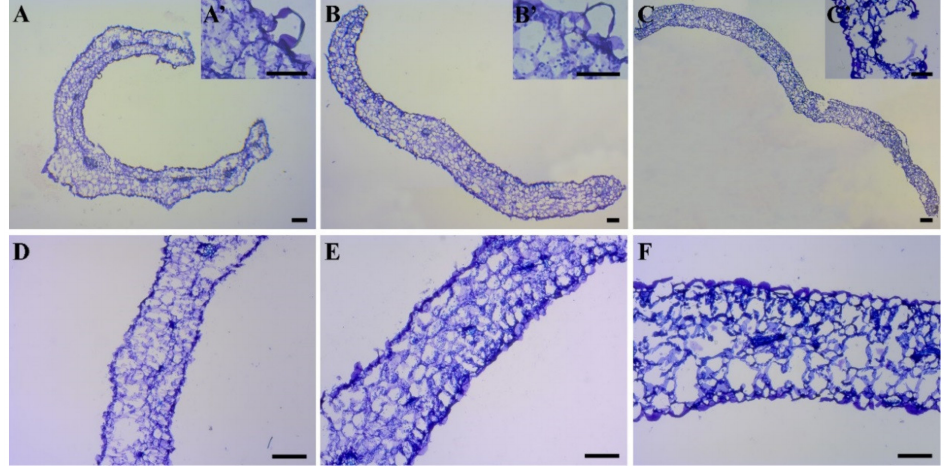
Figure 7. Sections of the leaf samples of M. maritima plants from a jar ( A , A (cid:48) , D ); Plantform ( B , B (cid:48) , E ) and in vivo plants ( C , C (cid:48) , F ). ( A – C ) Complete section; ( A (cid:48) – C (cid:48) ) wax gland section and ( D – F ) magnification of the leaf transversal section. In ( C ), bars = 200 µ m; in ( A , B , D – F , C (cid:48) ), bars = 100 µ m and in ( A (cid:48) , B (cid:48) ), bars = 50 µ